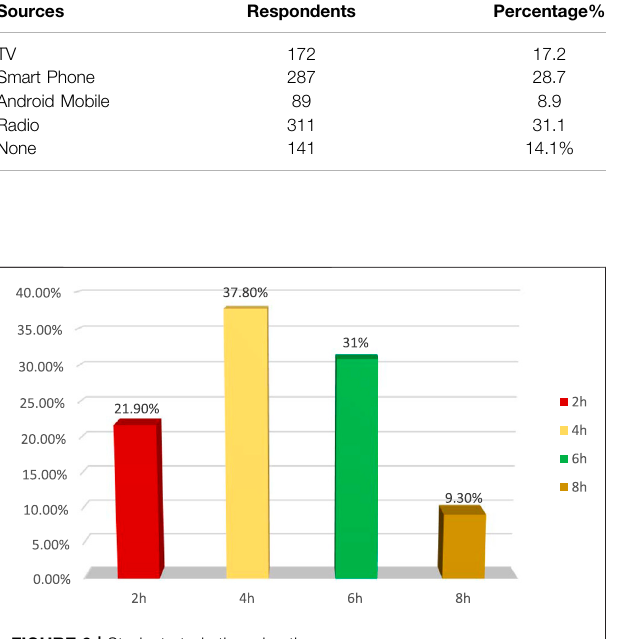
FIGURE 9 | Student study time